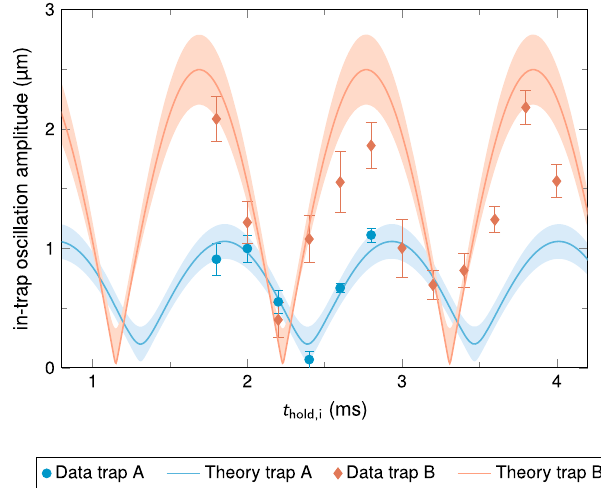
Fig. 2 | Realization ofa sub- μ m residual oscillationamplitude ofa transported BEC. Residualin-traposcillationamplitudeofaBECaftertransportasafunctionof the initial holdtime t hold,i fortwodifferent transportramps A (blue) and B (red).In sequence A (B) the atoms were transported along the z -direction over 0.42 (0.93) mm in 100 (150) ms from an initial trap of frequency ω z =2 π · 926Hz with initial oscillation amplitude of 0.22±0.05 μ m to a fi nal trap with frequency ω z =2 π · 110 (26.9)Hz.TransportBisspace-enabledduetoveryweak fi nal3Dtrapping.Afterthe transport residual oscillation amplitudes as low as 0.068±0.072 μ m (trap A) and 0.40±0.15 μ m (trap B) were measured. Changing the amplitude from 0.2 μ m to 0.068 (0.40) μ m while lowering the trap frequency by a factor of 8.4 (34) corre- spondstoareductionoftheoscillationenergybyafactorof738(359)fortrapA(B), respectively.Thedata(bluecirclesandreddiamonds)isconsistentwithanab-initio theoretical model (blue and red lines) based on a chip simulation and mean- fi eld BEC dynamics (see Methods). The error bars and shaded areas show the 1 σ - con fi dence bounds of the fi ts and the model,